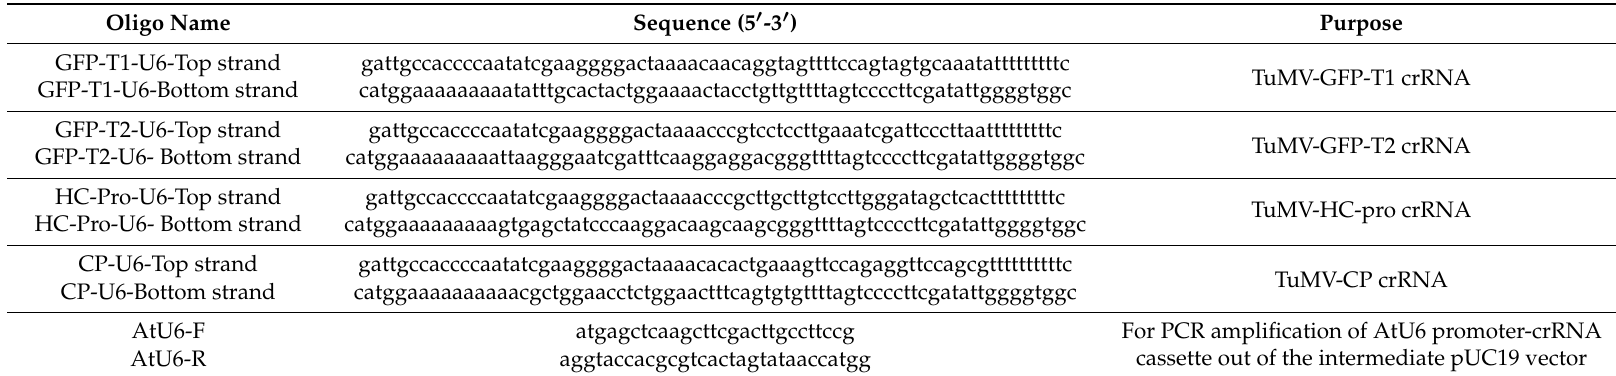
Table 1. Oligos used in this